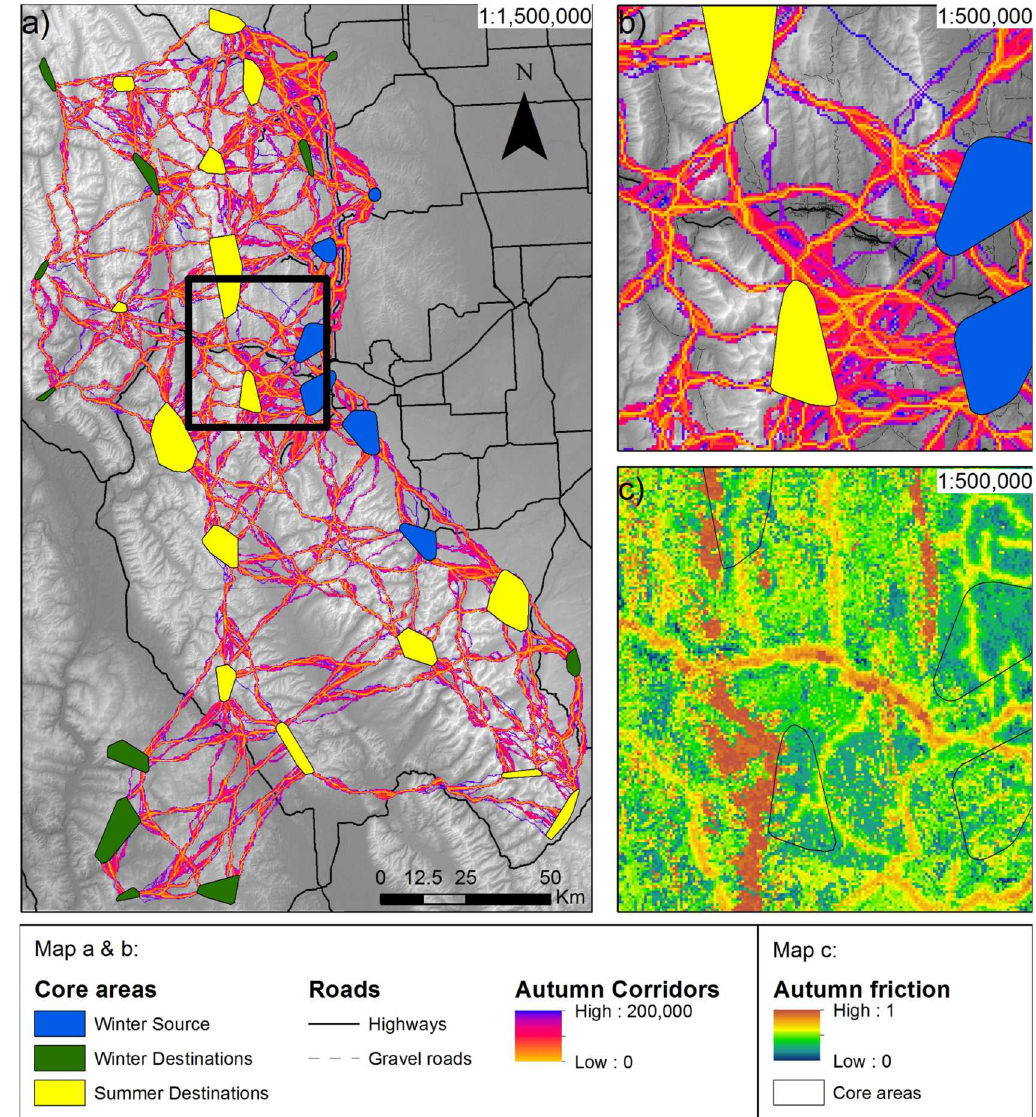
Fig 5. Corridor map of autumn movements connecting summer ranges with winter ones. a) Normalized least- cost-corridors, with low values as optimal, connectingsummer with winter core areas; b) close up section along highway3; c) close up friction map produced from autumn SSFs. Note that elk are predicted to move parallelor perpendicular to highway3 (map b), in contrast to what depicted in S6 Fig, where elk are predicted to move along highway3 at the bottom of the valley, which would be the movement if there were no